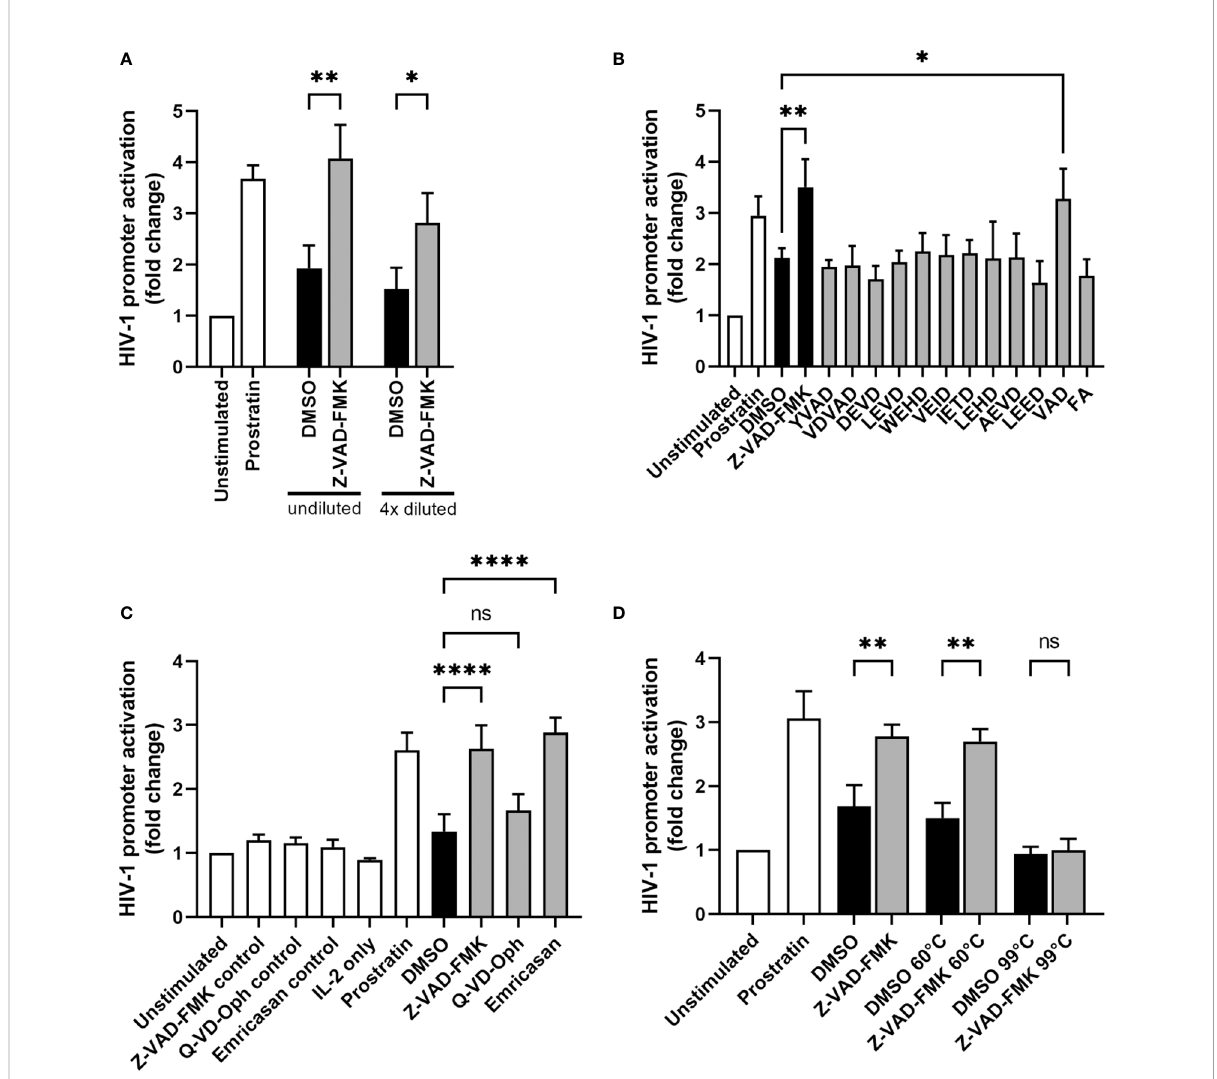
FIGURE 3 Supernatants of pan-caspase inhibitor-treated NK cells induce HIV-1 promoter activity. (A) KHYG-1 cells were incubated with Z-VAD-FMK or only DMSO. After 24 h, supernatants were collected and added to reporter cell line TZM-bl. Activation of the HIV-1 LTR promoter was assessed by subjecting these cells to a luciferase assay (n=3). Luminescence values of unstimulated cells was set to 1. TZM-bl cells incubated with LRA prostratin served as positive control. (B) KHYG-1 cells were incubated with various speci fi c caspase inhibitors and their supernatants were analyzed as in (A) (n=3). All individual caspase inhibitors had the same chemical structure as Z-VAD-FMK, except for the varying peptide sequence. (C) KHYG-1 cells were incubated with various pan-caspase inhibitors and their supernatants were analyzed as in (A) (n=4). TZM-bl incubated with IL-2 or pan-caspase inhibitors were used as controls. (D) KHYG-1 cells were incubated with Z-VAD-FMK and their supernatants were heat-inactivated at either 60°C, 99°C or left untreated before adding to TZM-bl cells and performing a luciferase assay (n=2). Data points are plotted as mean ± SD. (ns, non-signi fi cant; *p < 0.05, **p < 0.01, ****p < 0.0001;